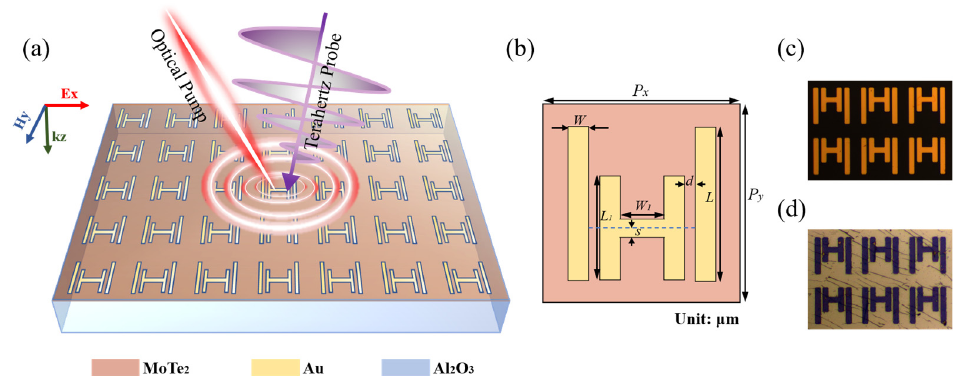
Figure 1. Schematic and working principle of the designed switchable EIT metasurface covered by the 10 ‐ nm thick MoTe 2 multilayer. ( a ) An artistic illustration of the hybrid metasurface under illumination of the 800 nm femtosecond laser and THz probe pulse; ( b ) the geometrical configuration of one proposed unit cell with the following structure parameters: Px = 56 μ m, Py = 58.8 μ m, W = 5.6 μ m, L = 42 μ m, W 1 = 12.6 μ m, L 1 = 28 μ m, d = 3.5 μ m, and s = 2.8 μ m. ( c , d ) Optical microscope images of the fabricated metasurface, without MoTe 2 and with 10 ‐ nm thick MoTe 2 coating, respectively.